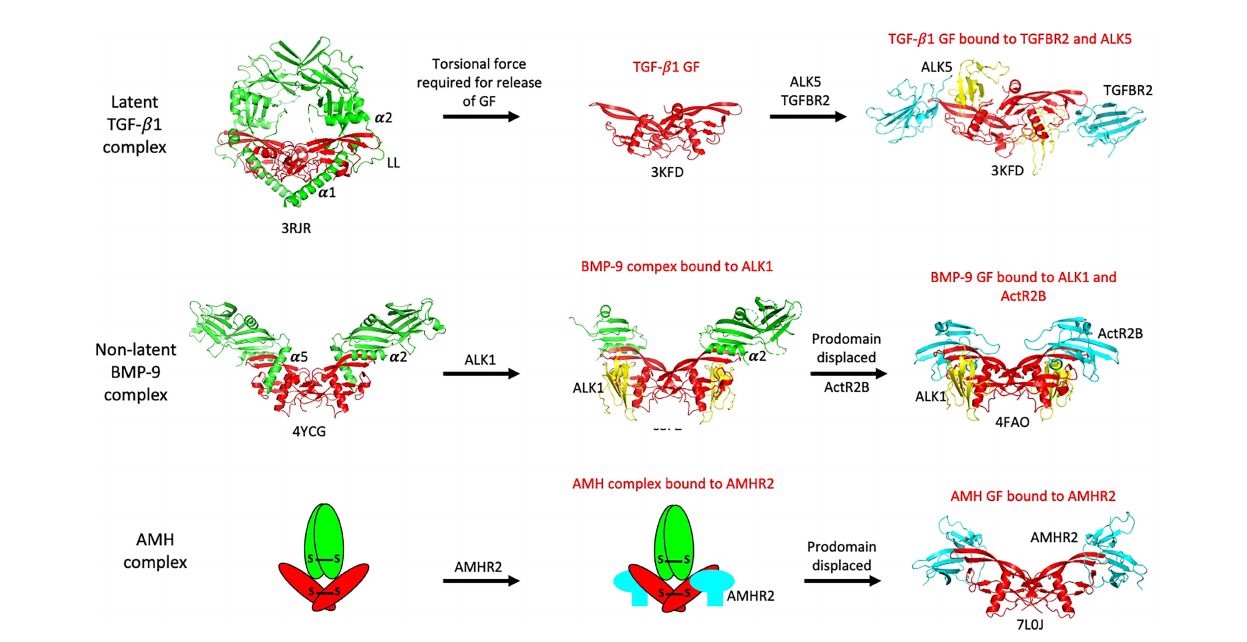
FIGURE 3 | Summary of how various TGF- b family ligands access their receptors. The latent TGF- b 1 complex requires torsional force to liberate its GF and allow access to receptors. The non-latent BMP-9 complex can bind to its type I receptor, ALK1, without inducing prodomain displacement, while the AMH complex can bind to AMHR2 in solution without inducing prodomain displacement. Prodomains are shown in green, GFs in red, type I receptor ECDs in yellow, and type II receptor ECDs in cyan. The PDB fi le names are shown beneath each structure. The a 1-, a 2-, and a 5-helices and latency lasso (LL) in the prodomains are labeled; these elements are located in close proximity to receptor binding sites on the